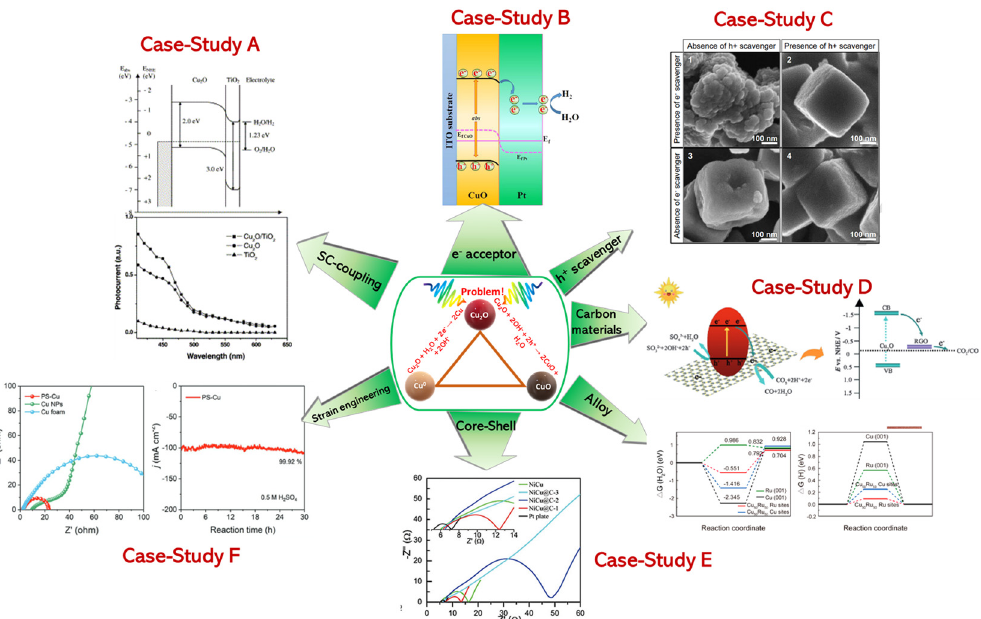
Figure 3. Various Case-Studies exemplifying methods to address the problem of photocorrosion. Case − Study A : Energy band diagram of Cu 2 O/TiO 2 composite (top) and normalized spectral re- sponses (bottom). Reprinted from [19]. Copyright 2003, with permission from Elsevier; Case − Study B : Schematic illustration of charge separation-transfer of CuO/Pt composite photocathode during photoelectrochemical (PEC) water splitting. Reproduced from Ref. [26] with permission from the Royal Society of Chemistry; Case − Study C : SEM images of cubic-Cu 2 O NPs showing the effect of hole and electron scavenger. Reproduced with permission from ref. [31]. Copyright 2018 Wiley − VCH; Case − Study D : Charge transfer in Cu 2 O/RGO composites facilitating photocatalytic conversion of CO 2 . Reproduced with permission from ref. [32]. Copyright 2014 Wiley − VCH; Case − Study E (Alloy): Calculated adsorption free energy diagram for the Volmer step (left) and for the Tafel step (right). Reprinted with permission from [28]. Copyright 2020 American Chemical Society; Case − Study E (Core-Shell) : Nyquist plots of various NiCu catalysts. Reproduced with per- mission from ref. [33]. Copyright 2017 Wiley-VCH; Case − Study F : Nyquist plots and long-term stability (30 h) of PS-Cu, Cu NPs, and Cu foam. Reproduced with permission from ref. [27]. Copy- right 2022 Wiley − VCH.